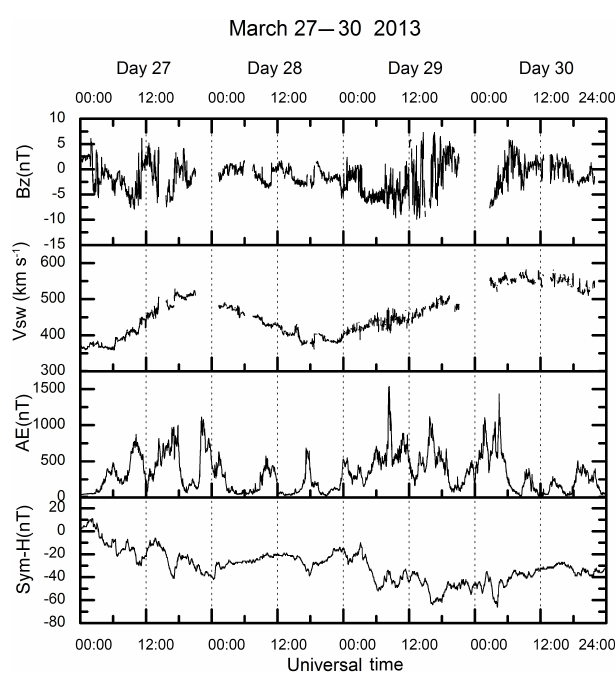
Figure 5. Zoomed-in view of the HILDCAA period which occurred on 27–30 March 2013 showing the IMF B z component, solar wind speed V SW , AE index and Sym-H